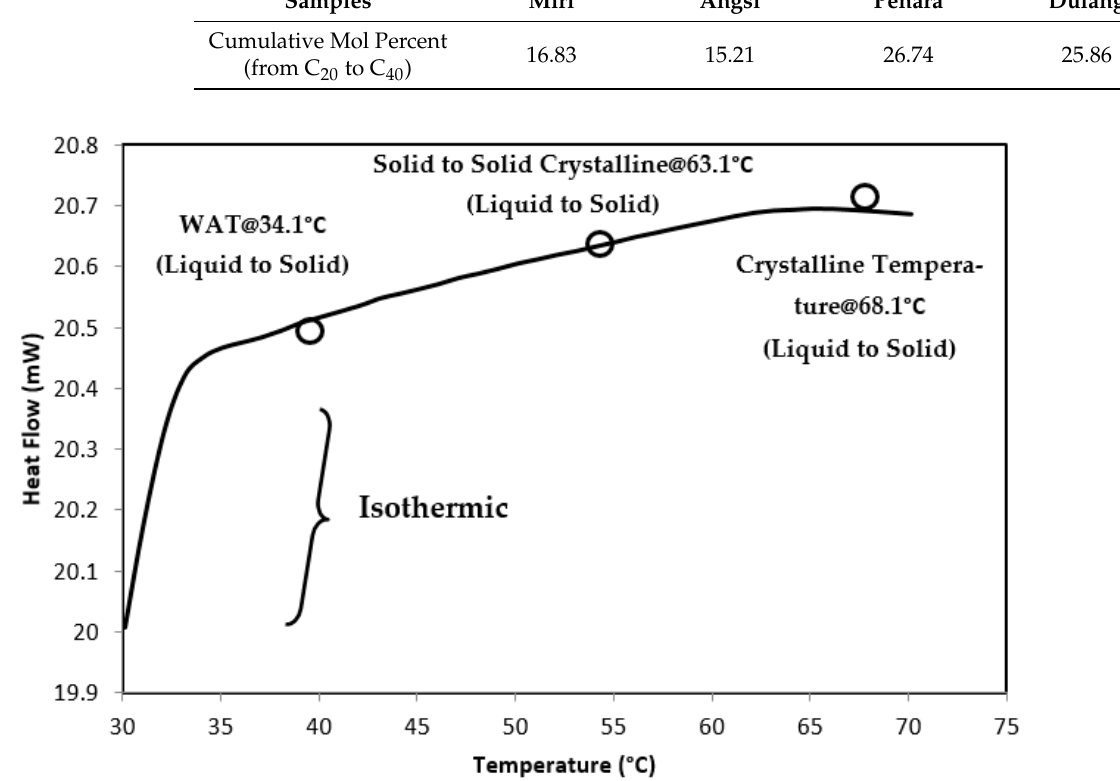
Figure 1. Heat flow at various temperatures for Angsi crude. Figure 1. Heat fl ow at various temperatures for Angsi crude.